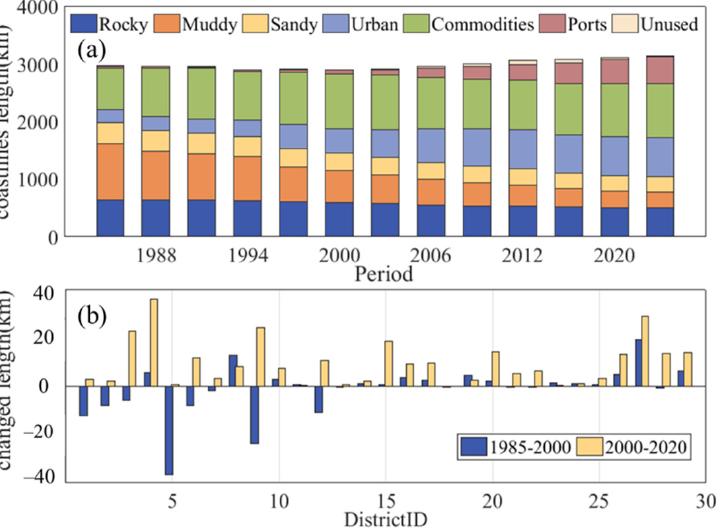
Figure 3. ( a ) Historical changes of length and composition of coastline in Fujian province; ( b ) Changes in length of coastline in 29 counties during two periods.